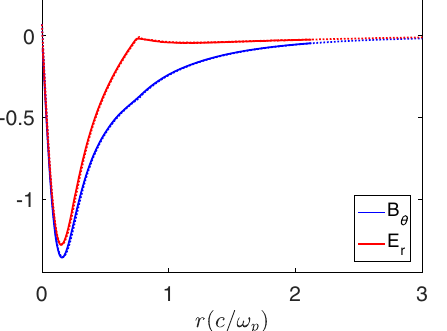
FIG. 3. Transverse field components B θ and E r (in units of mc ω =e ) at ξ ¼ ξ ¼ 6 . 5 as functions of r . The solid lines show p w results from our code ( PLEBS ) while the dotted lines show Q UICK PIC data for a witness current of 2.55 kA. Since Q UICK PIC is a 3D code utilizing a Cartesian transverse grid, the values for B E θ and r have been obtained using the components (respectively) at the y ¼ 0 plane. A slope discontinuity at r ≈ 0 . 75 corresponds to the bubble boundary (see Fig. 1, left plot). PLEBS data for r > 2 . 15 are omitted in order to highlight the Q UICK PIC